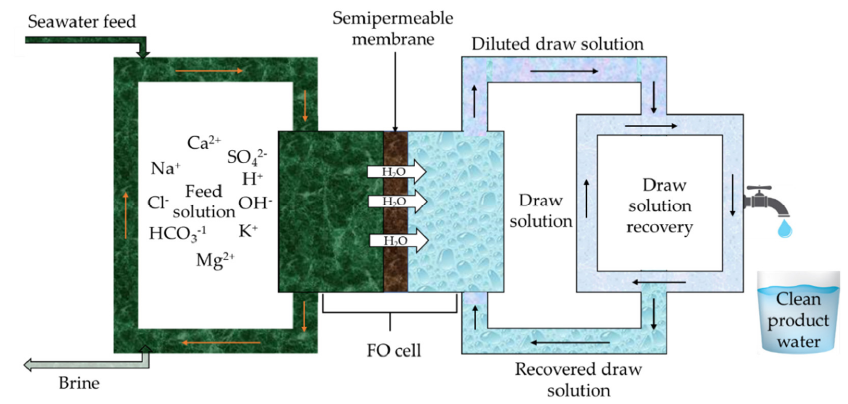
Figure 3. A schematic of the forward osmosis (FO) process.